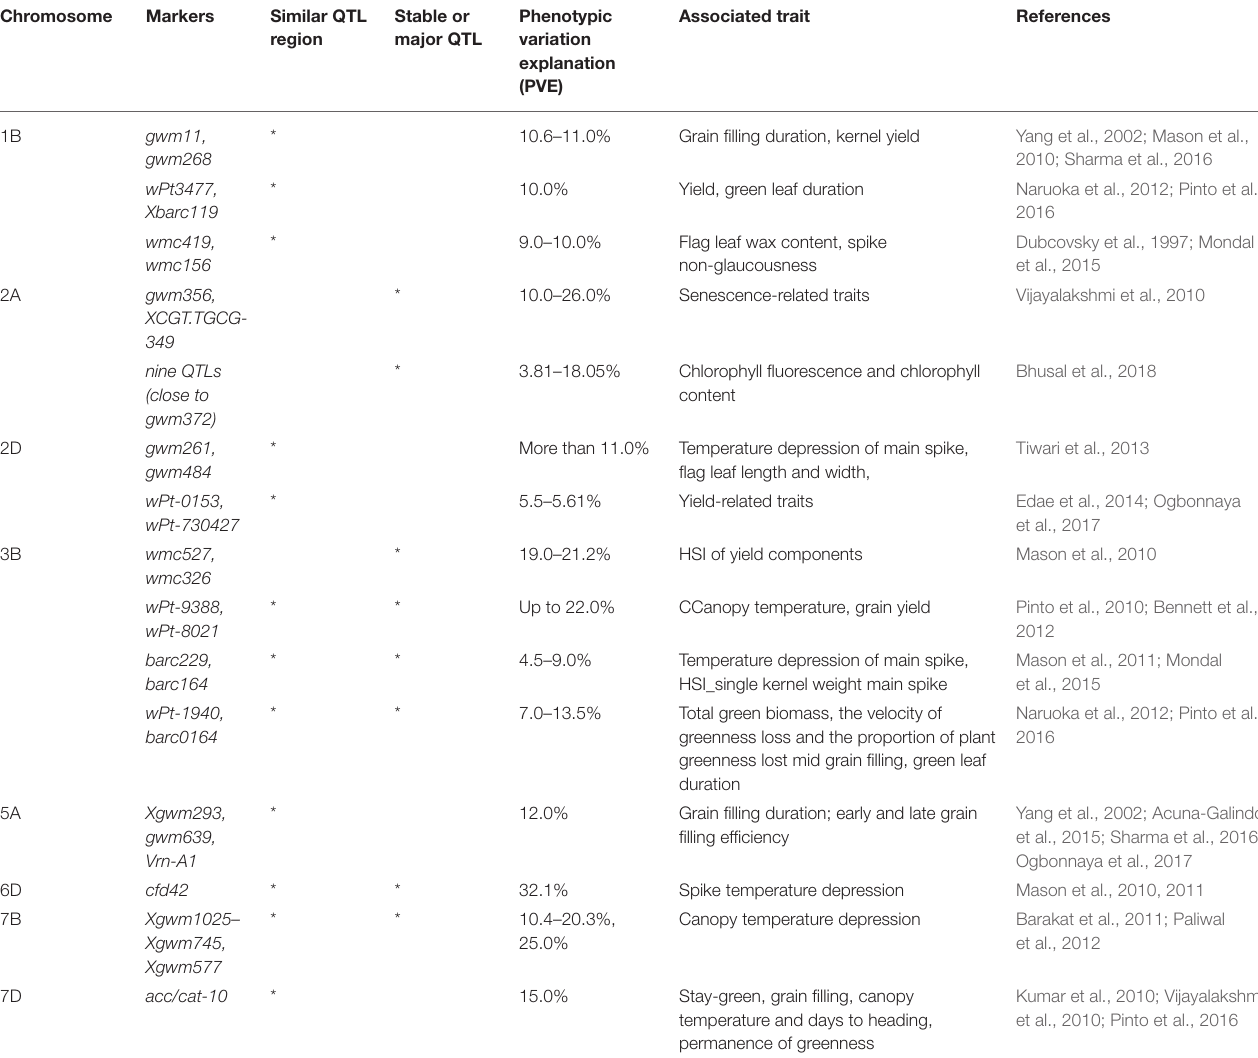
TABLE 4 | QTLs for traits associated with terminal heat tolerance in wheat.